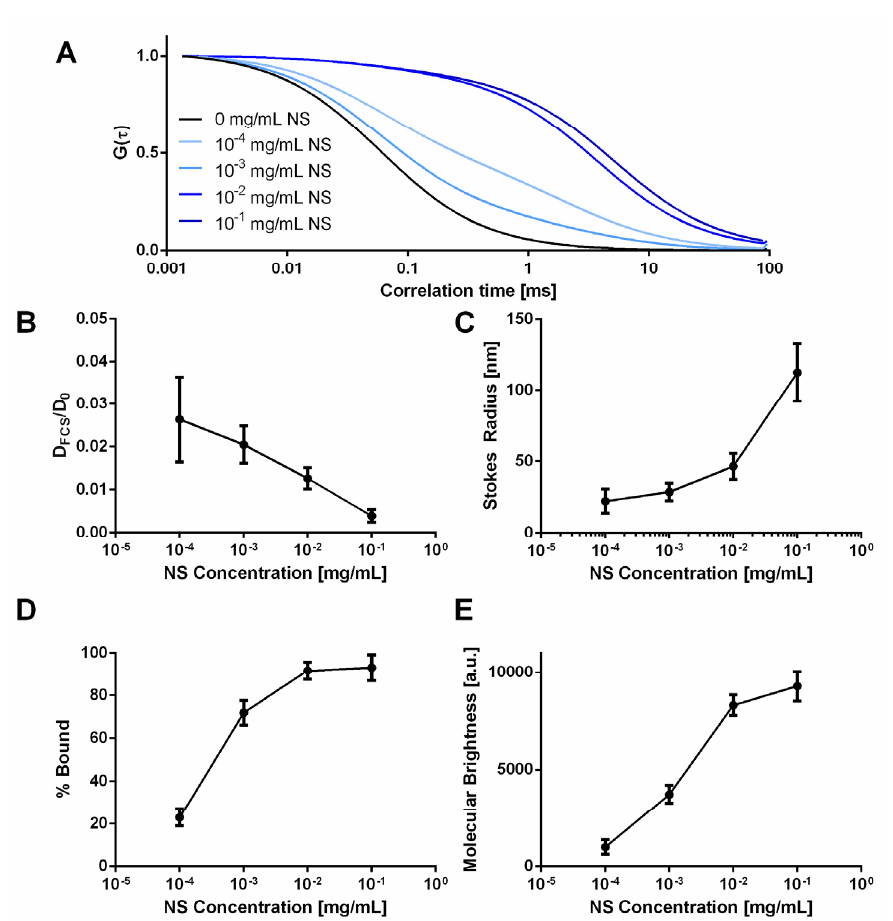
Figure 3. Effect of NS concentration on AO diffusivity, molecular brightness and percent AO bound to NS. ( A ) Normalized autocorrelation functions of AO for various NS concentrations. ( B ) Normalized diffusivities of AO incubated with NS compared to free AO in water. ( C ) Calculated Stokes radius of NS/AO complexes with varying NS concentrations. ( D ) Calculated percentage of AO bound to NS particles as a function of NS concentration. ( E ) Molecular brightness of AO as a function of NS concentration.